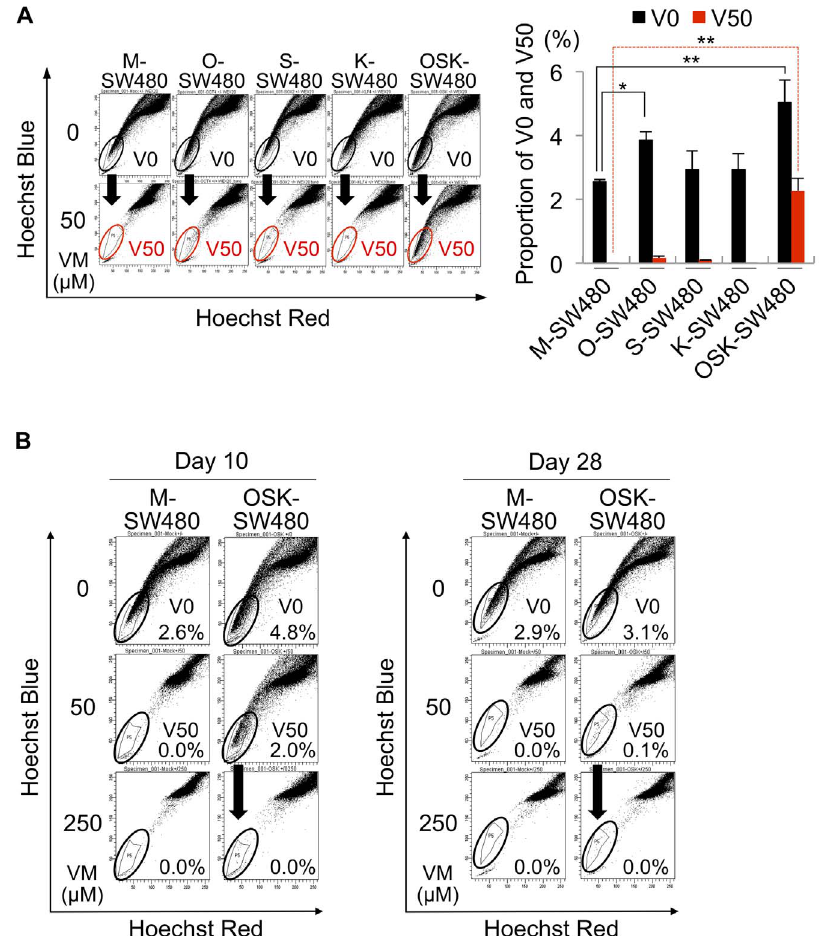
Figure 3. Efflux activity for Hoechst33342. (A) The OSK-SW480 cells included a population of cells unlabeled by 5 m g/ml of Hoechst33342 with the co-administration of 50 m M of verapamil (VM). We designated the cells unlabeled by Hoechst33342 without VM and with 50 m M of VM as V0-cells and V50-cells, respectively. The left panel shows representative dot plots of labeled and unlabeled cells at day 10 after transduction. The right panel shows the results of three independent experiments. The V0 subpopulation was increased in the O- and OSK-SW480 cells. The V50-cells were obviously seen in the OSK-SW480 cultures. The error bars indicate the SD (n=3). *P , 0.05, **P , 0.01, Dunnett’s test. (B) Dye efflux activity at day 10 (left panel) and day 28 (right panel) after transduction. The V50-cells disappeared under the treatment with the co-administration of 250 m M of VM even in the OSK-SW480 cells. The proportion of the OSK-V50 cells decreased with time.